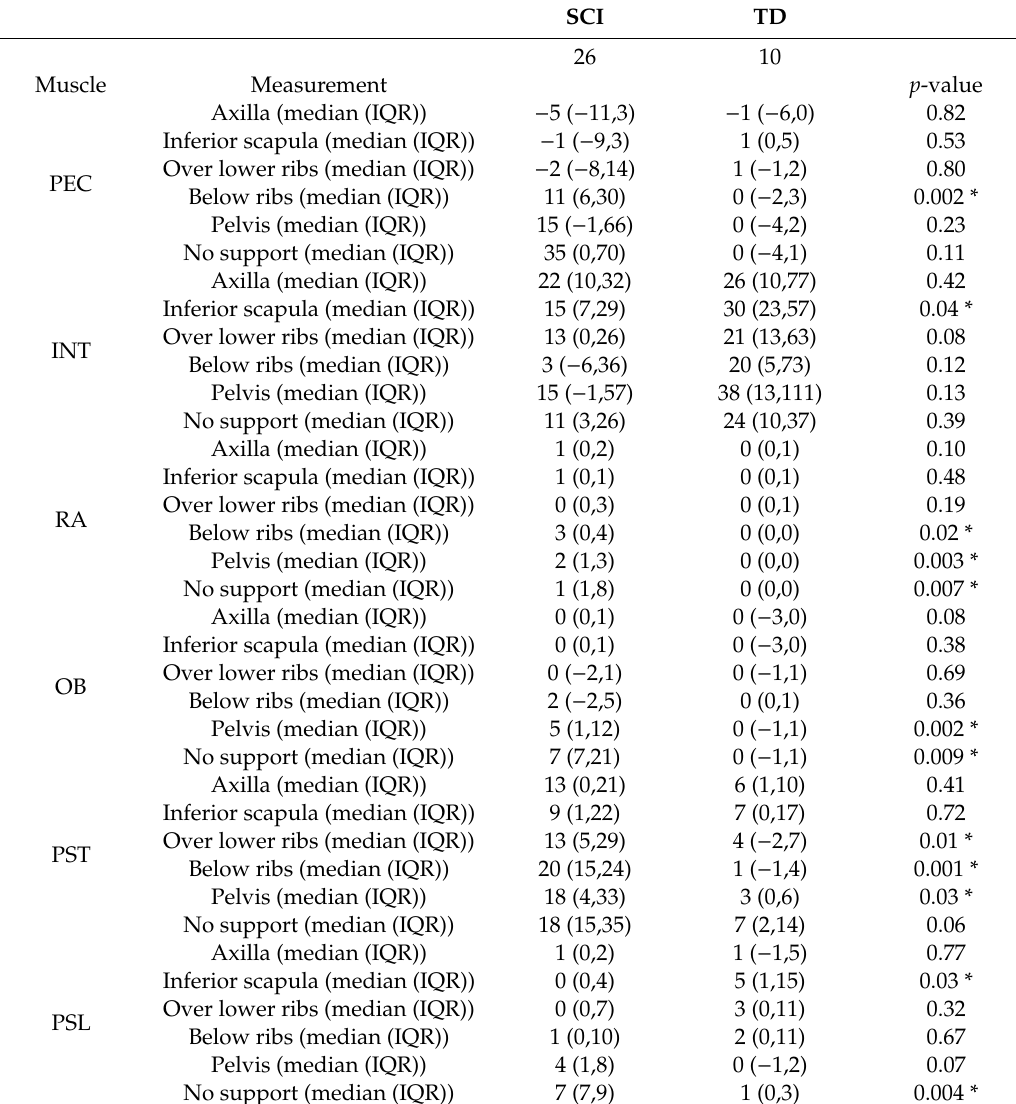
Table 3. Root mean square (RMS) values of trunk muscles during SATCo assessment in typically developing children and in children with spinal cord